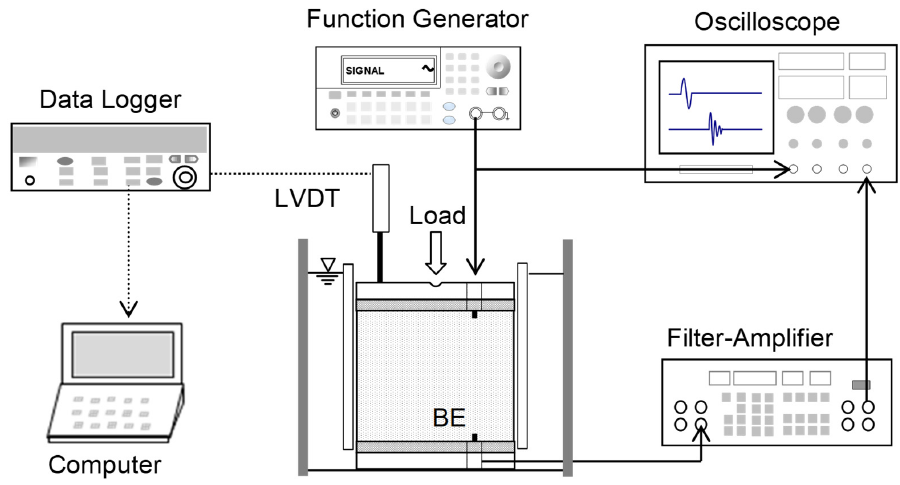
Figure 7. Floating oedometer cell with bender elements and peripheral devices for measurement of shear waves (note: BE denotes bender element).